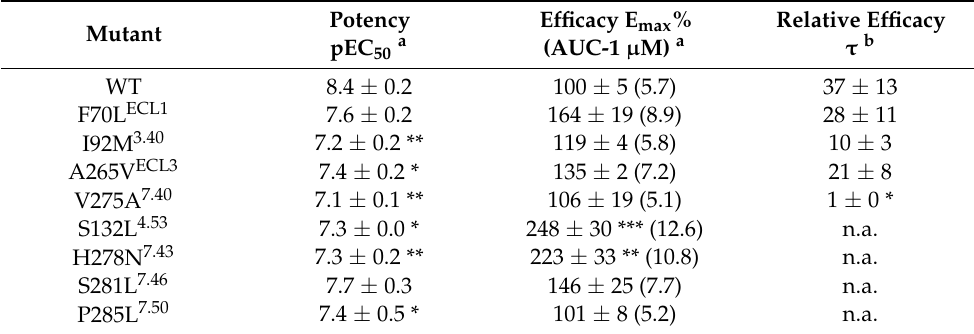
Table 2. Potency and efficacy of NECA stimulation of the wild-type (WT) and mutant A 2A ARs derived from cell-morphology-assay